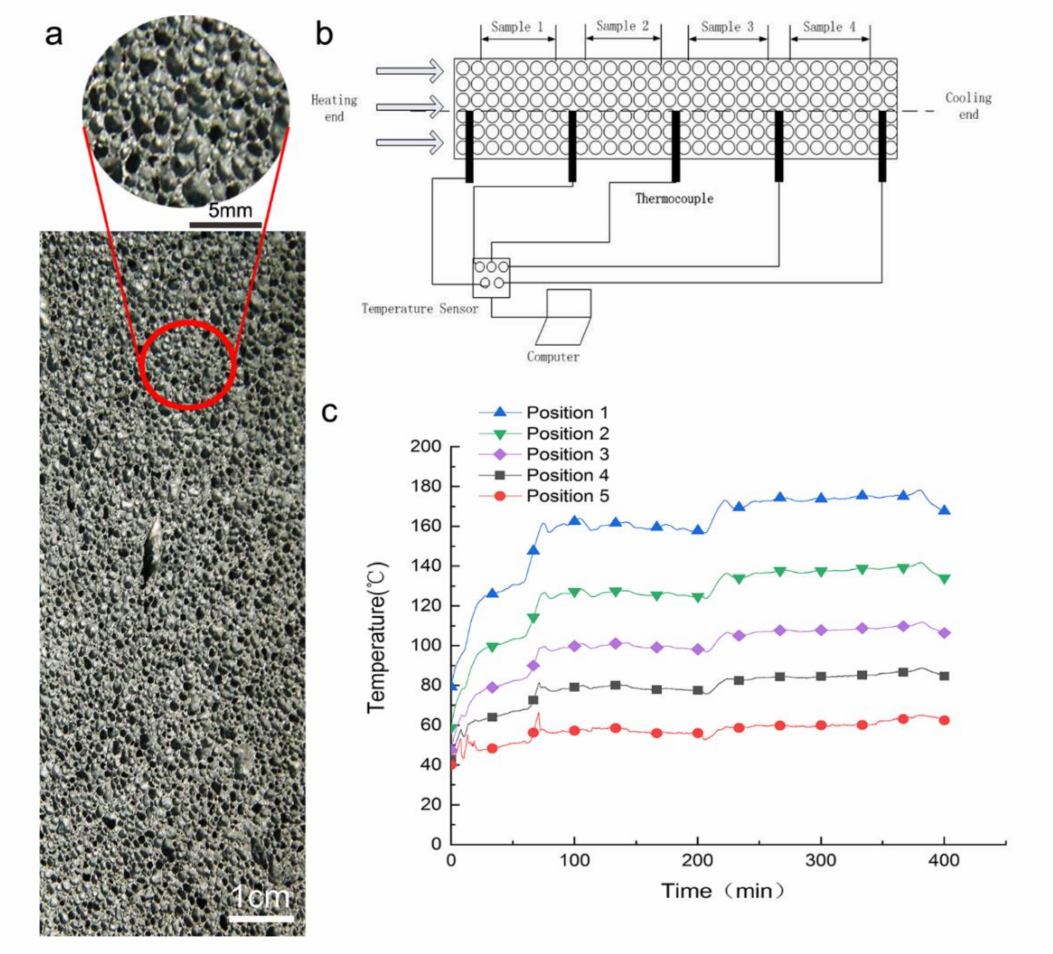
Figure 1. ( a ) Section image of the Al-Cu-Ca alloy foams ( b ) Schematic diagram of temperature detection during aging ( c ) Temperature distribution in samples during